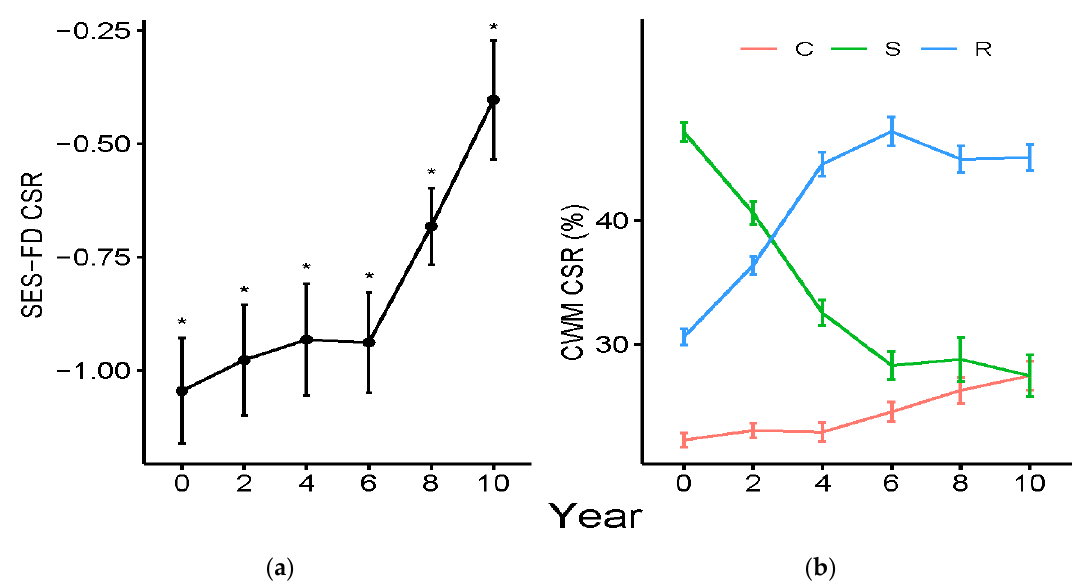
Figure 6. Trends of standardized effect size of functional diversity (SES-FD); ( a ) and community weighted means (CWMs); ( b ) (mean ± s.e.) for Grimes’s CSR strategies under twice-a-year mowing. Year 0 (before treatment) refers to 2010; years 2, 4, 6, 8, and 10 correspond to 2012, 2014, 2016, 2018, and 2020. The asterisk ( * ) indicates a distribution of SES-FD significantly different from zero after a one-sample two-tailed t -test ( p < 0.05).